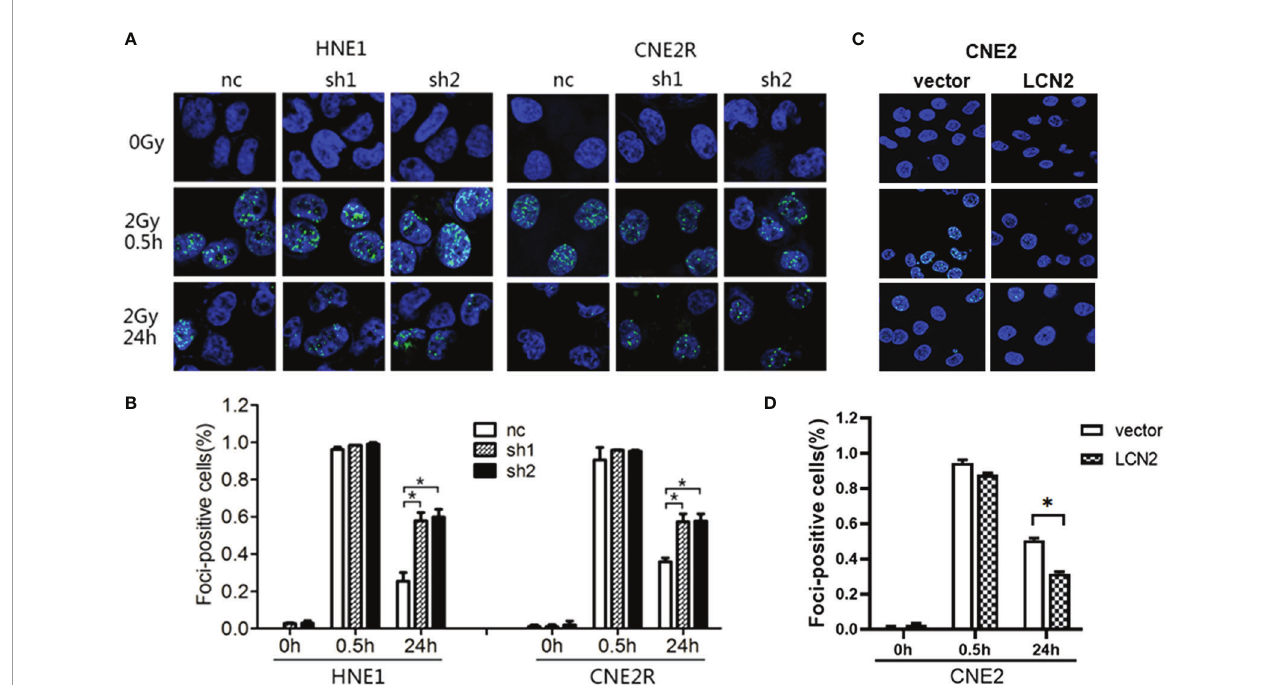
FIGURE 3 | LCN2 regulates the radiosensitivity of nasopharyngeal carcinoma (NPC) cells. (A, B) The DNA double-strand break repair capacity was impaired in HNE1 and CNE2R cells with LCN2 knockdown, as evidenced by the greater number of g H2AX-positive LCN2-depleted cells when compared with that of control cells. * P < 0.05. (C, D) The DNA double-strand break repair capacity was enhanced in LCN2-overexpressing CNE2 cells based on the percentage of g H2AX-positive cells. * P <